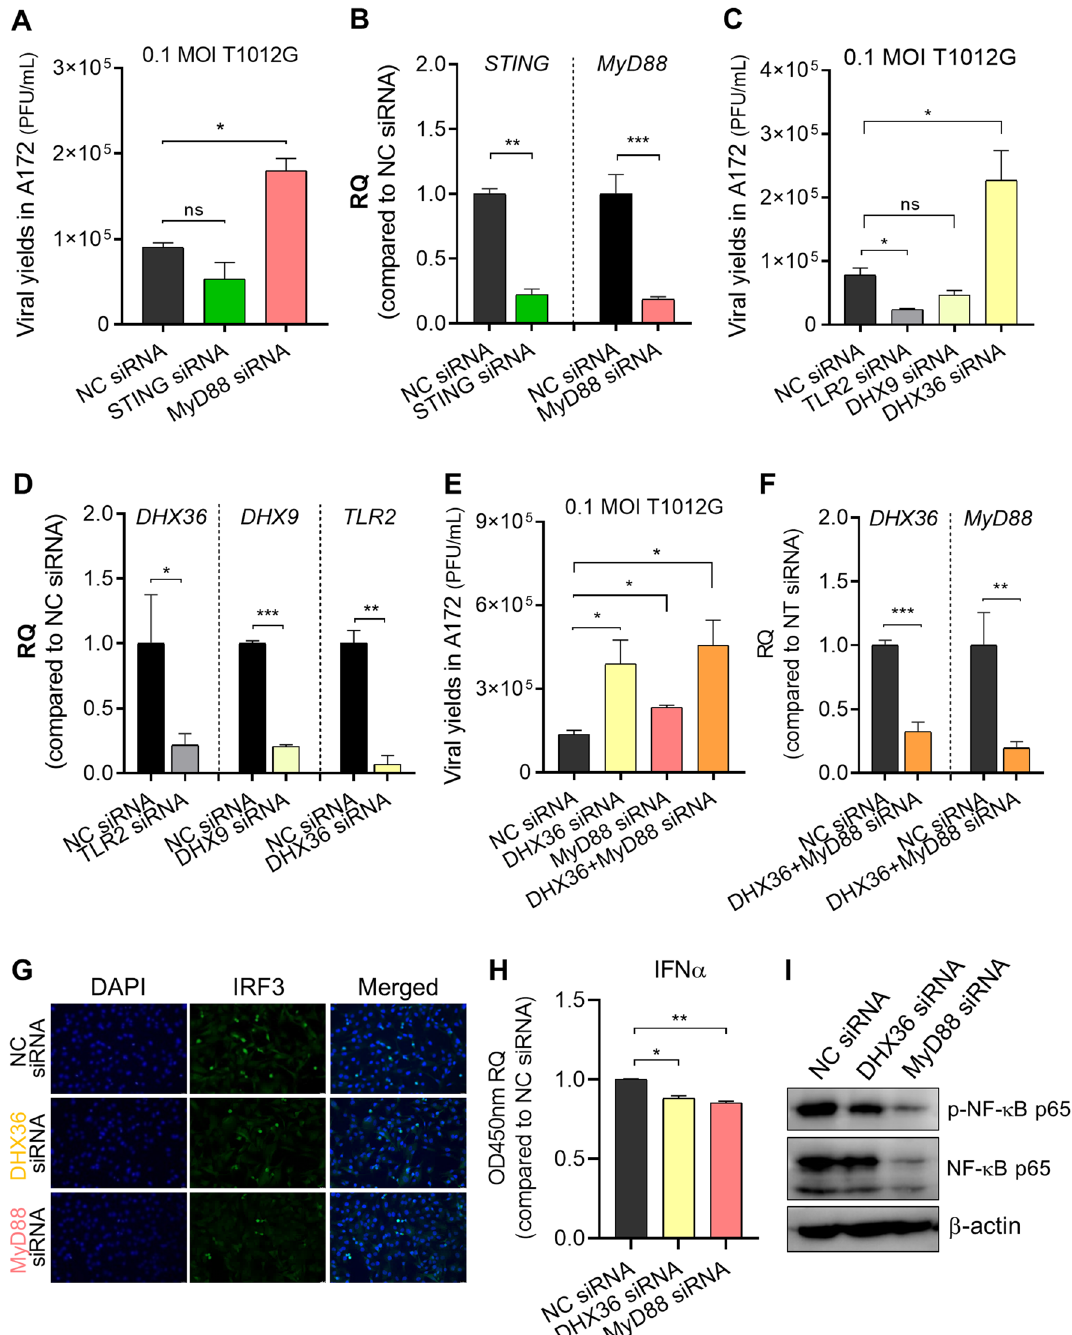
Figure 5. Identification of immune factors responsible for increased virus production in the resistant cell line A172 mediated by Mx2 depletion. ( A – F ) A172 cells were transfected with indicated siRNAs or NC siRNA, followed by exposure to 0.1 MOI oHSV-1 T1012G for 2 h at 24 h post-transfection. Virus progeny were harvested at 24 h post-infection and titered in Vero cells. ( A ) Viral yields in MyD88 or STING-depleted A172 cells; ( C ) Viral yields in DHX36, DHX9 or TLR2-depleted A172 cells; ( E ) Viral yields in MyD88, DHX36 or both-depleted A172 cells; ( B , D , F ) Knockdown efficiency of MyD88, STING, DHX36, DHX9 and TLR2 siRNA were analyzed by the qPCR assay. RQ: relative quantity, compared to transcript levels in NC siRNA-transfected A172 cells. Error bars represent SD. GAPDH serves as a normalization control. A172 cells were depleted of DHX36, MyD88 or mock- depleted by siRNA transfection, 24 h later, cells were harvested for the following indicated tests. ( G ) Investigation of nuclear IRF3 in A172 cells via immunofluorescence staining. ( H ) ELISA quantification of secreted IFNα in cell supernatant. RQ: relative quantity, values that correspond to optical densities at OD 450 nm compared to values in NC siRNA-transfected A172 cells. (* p < 0.05; ** p < 0.01; compared with NC siRNA-treated A172 cells. Error bars represent SD.) ( I ) Expression of effector proteins associated with the NF-κB signaling pathway. Blots were cut and probed with indicated antibodies, respectively. β-actin serves as a loading